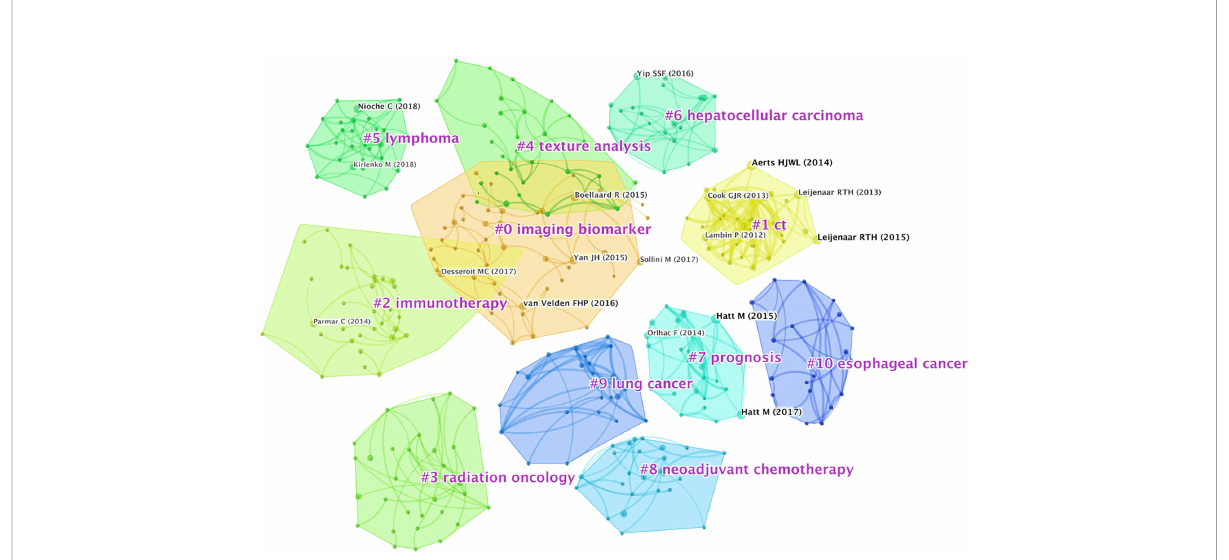
FIGURE 8 Analysis of author co-citation related to 18 F-FDG PET/CT radiomics research. N = 482, E = 837. The connection between the nodes represents the closeness in the relationship. The tighter the relationship is, the thicker the line is. The blue “ # ” labels show the cluster name, and the blocks of the same color are divided into studies on the same topic.